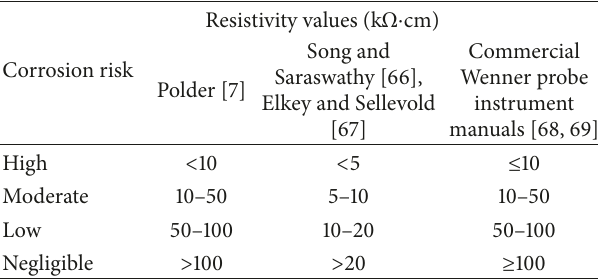
Table 6: Concrete resistivity and risk of corrosion of steel reinforce-